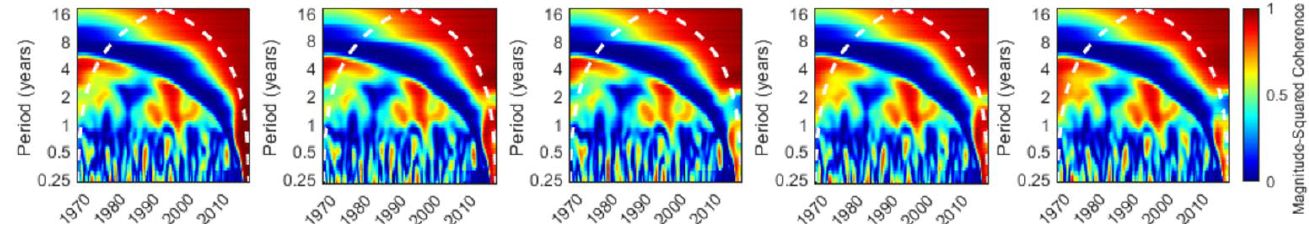
Figure 11. Wavelet coherence plot of Niño3.4 and DMI index from 1971–2021 with a different time lag (from left to right: same month, one month earlier of Niño3.4, two months earlier of Niño3.4, one month earlier of DMI, and two months earlier of DMI).